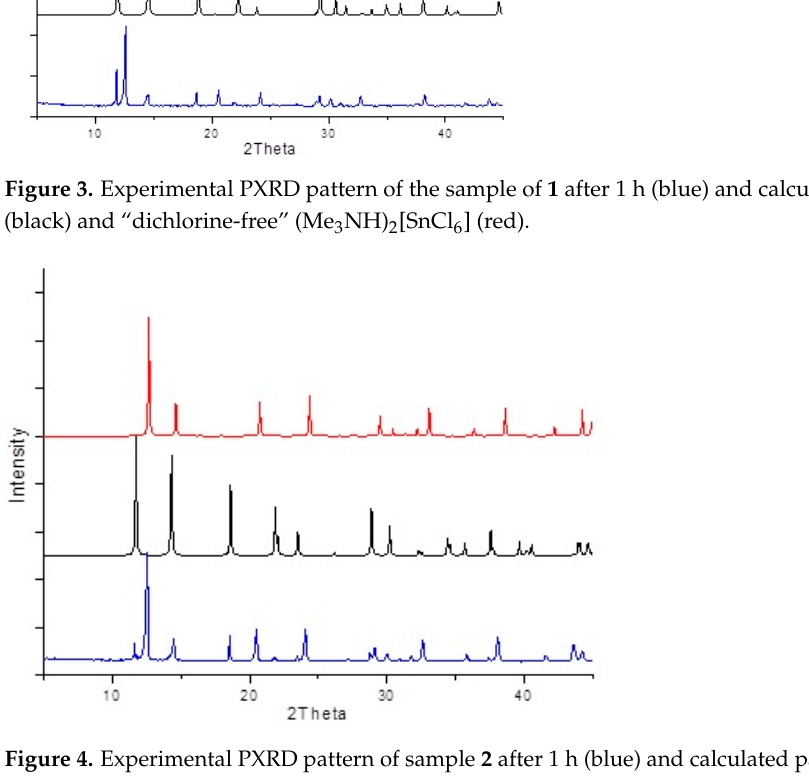
Figure 3. Experimental PXRD pattern of the sample of 1 after 1 h (blue) and calculated patterns of 1 (black) and “dichlorine-free” (Me 3 NH) 2 [SnCl 6 ] (red).